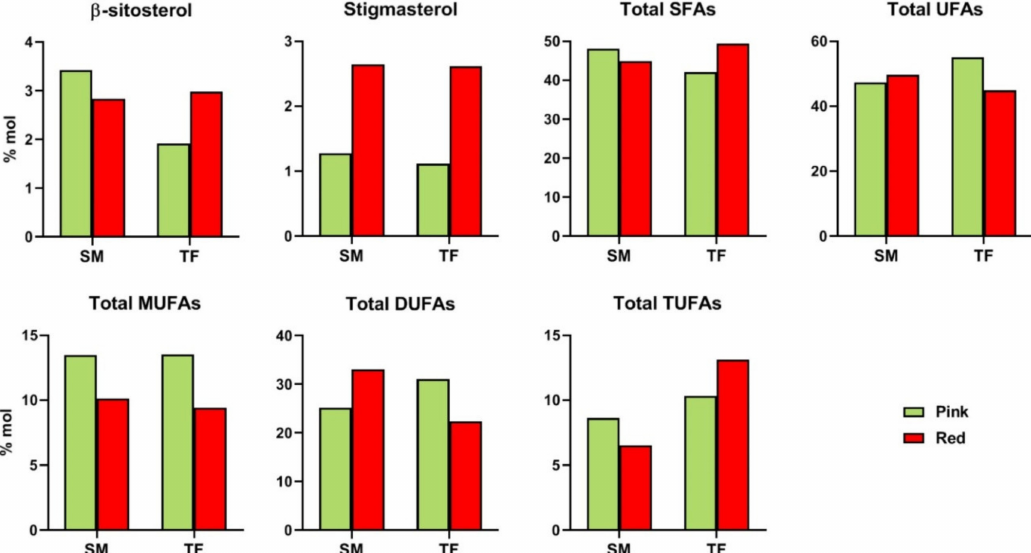
Figure 3. Histograms comparing the concentration (% molar) of metabolites present in tomato organic extracts from pink and red SM and TF. SFA: saturated fatty acids; UFA: unsaturated fatty acids; MUFA: mono-unsaturated fatty acids; DUFA: